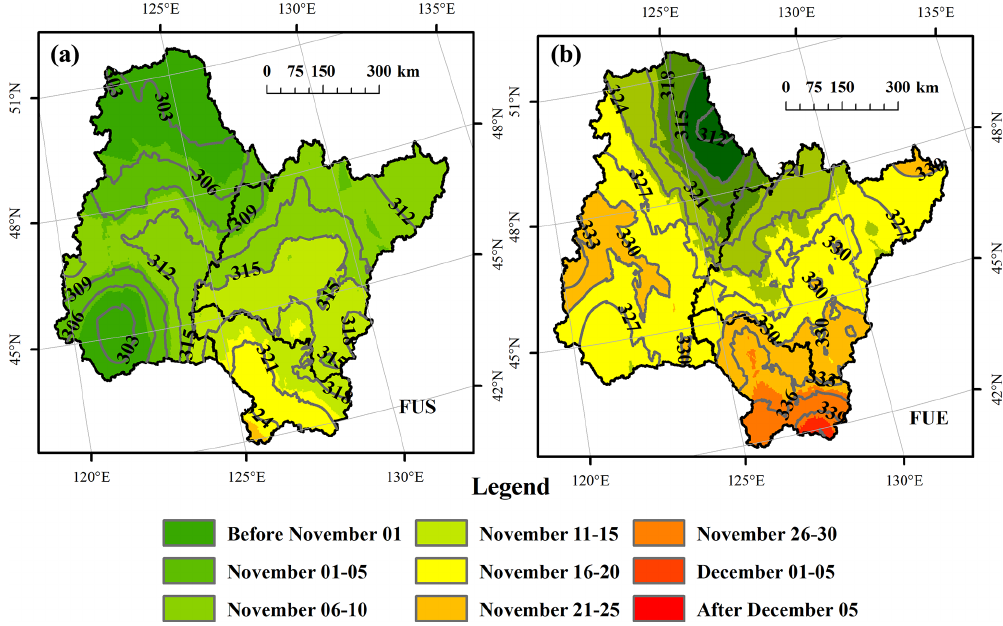
Figure 2. The average spatial distribution of freeze-up start (FUS) (a) and freeze-up end (FUE) (b) in the Songhua River Basin of northeast China from 2010 to 2015. The number labels indicate the day of year (DOY) of the isophenes.